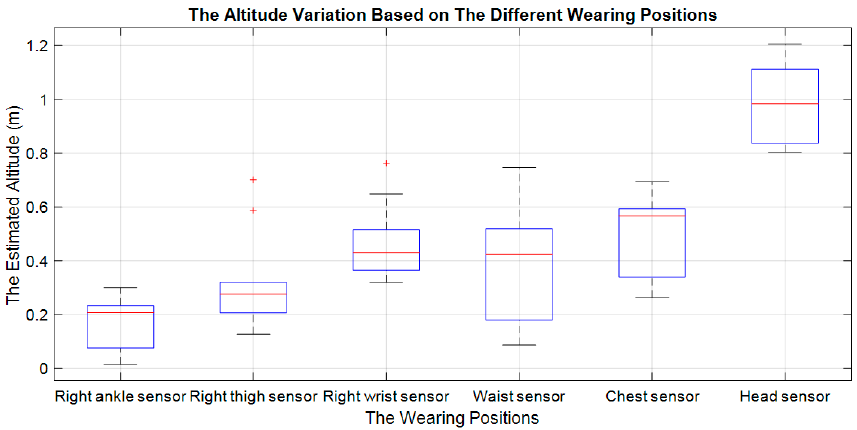
Figure 19. The altitude variations based on the di ff erent mounting positions of the fall events in public dataset 31.